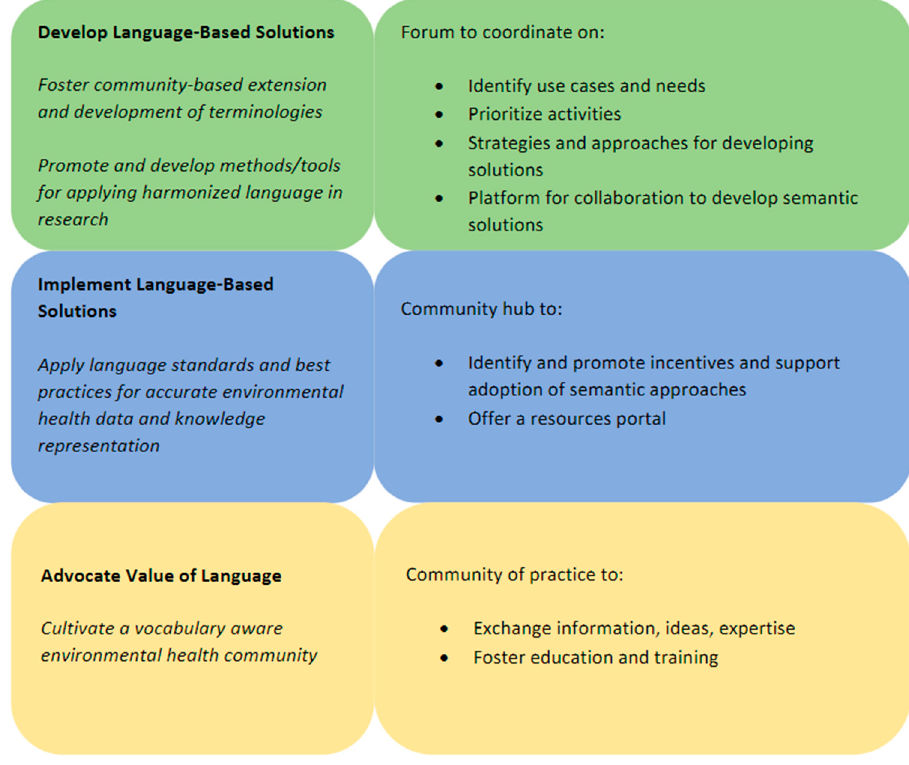
Figure 5. Proposed goals and roles of EHLC.